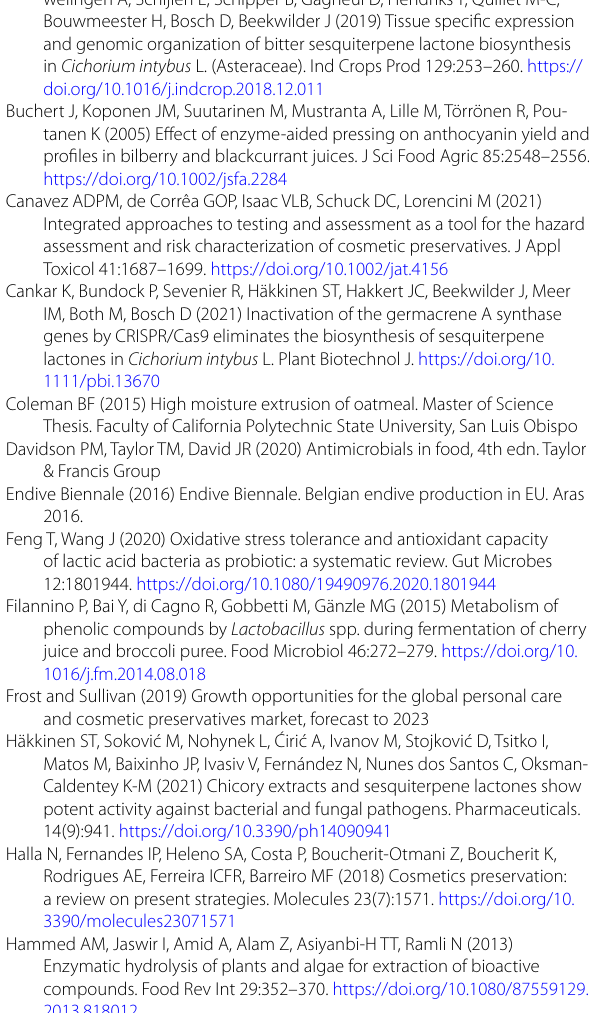
Additional file 1: Table S1. Composition of the chicory samples. Table S2. Composition of standard cream formula. Table S3. Scenarios considered. Table S4 . Applied process parameters for mass and energy calculation based on experimental work and literature. Table S5 . Applied economic and financial parameters and process operation strategy (location the Netherlands). Table S6. Amounts of selected carbohydrates, phenolic compounds and sesquiterpene lactones in the three chicory samples. Dry matter was measured by weighing. Table S7 . Activity profiles and protein content (mg/ml) of used enzymes. Activities are expressed as nkat/ml, except cellulase activity as FPU/ml, and assayed in pH 5, except inulinase in pH 6. Table S8. MSn results per selected peak of LC‑Orbitrap‑ FTMS chromatogram of sample 3A (pectinase xylanase) (see Fig. S1): + The retention time, the selected mass for fragmentation, the characteristic mass fragments and the tentative peak identification. Table S9. Overall mass balance of the process (baseline, scenario 1). Fig. S1. LC‑Orbitrap‑